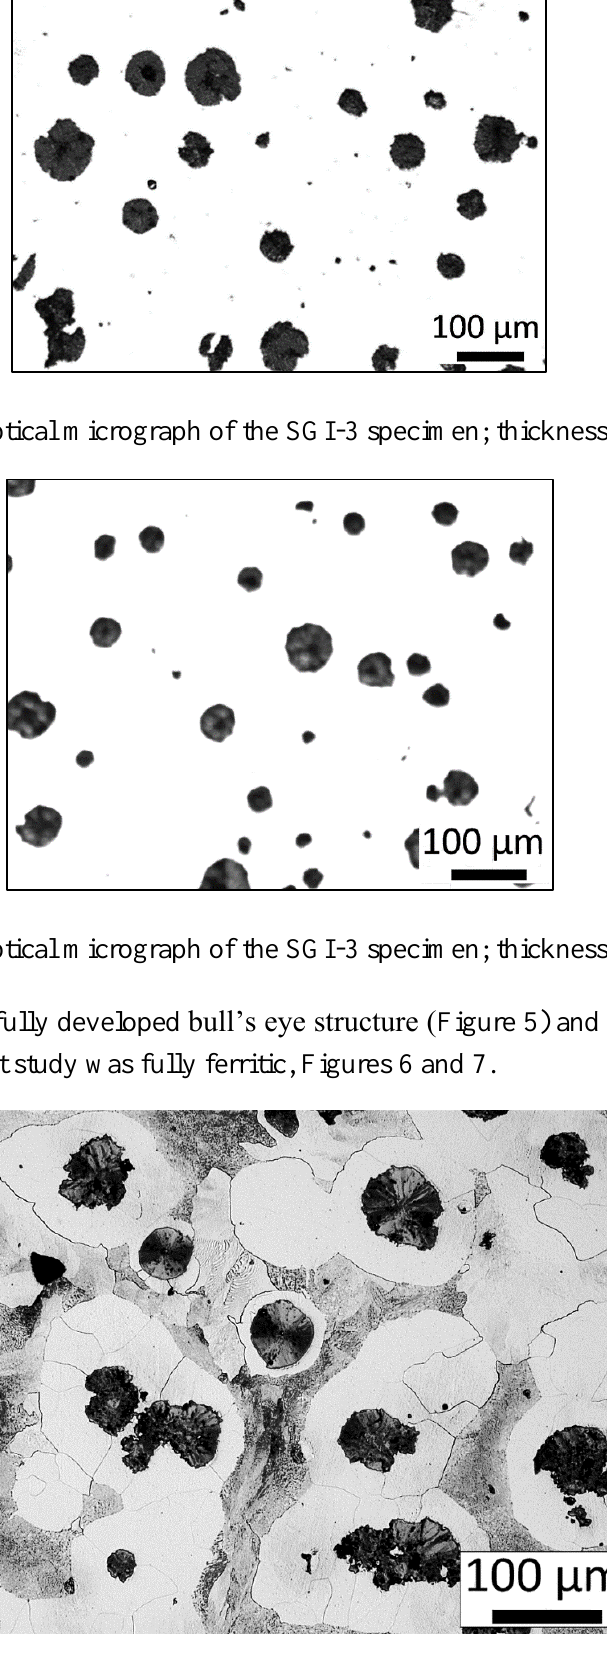
Figure 5. Optical micrograph of the SGI-3 specimen; thickness: 50 mm (Bull’s